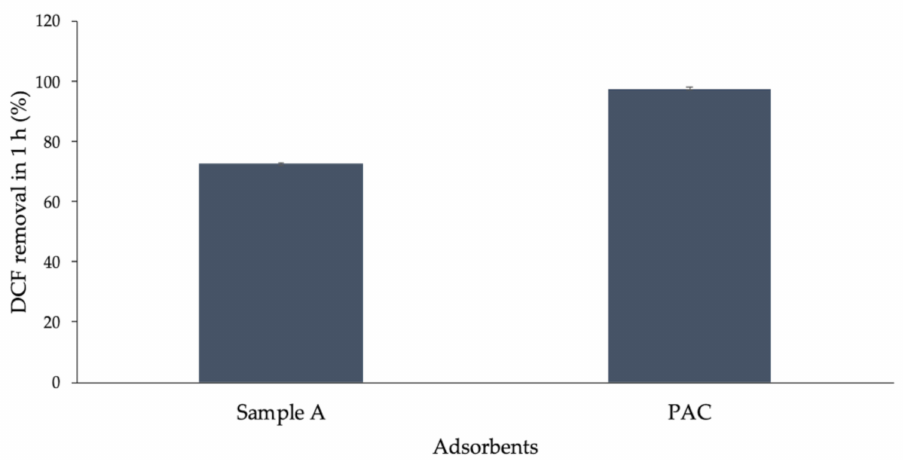
Figure 6. Diclofenac removal (R%) for sample A compared with powdered activated carbon (PAC) in 1 h test. An instrumental error equal to 0.6% for the experimental data was